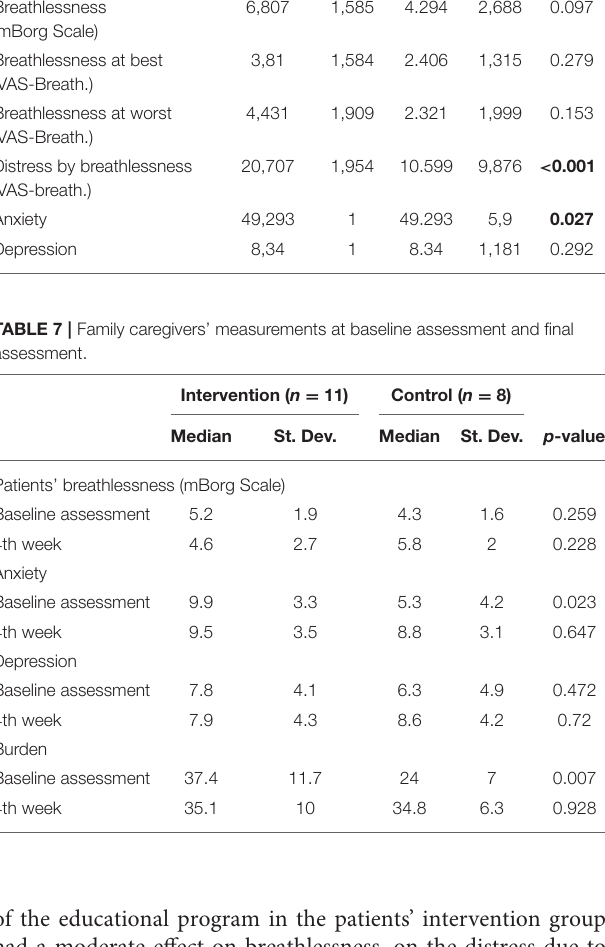
TABLE 6 | Time X Group interaction for the possible effect of the educational programme to the intervention group- patients.